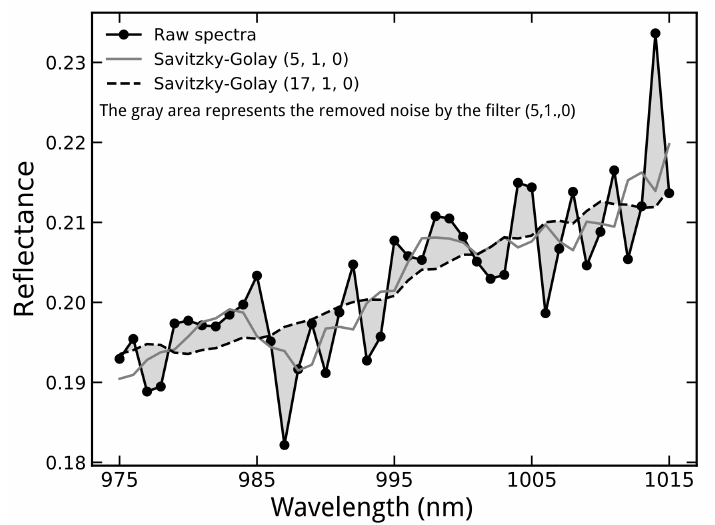
Figure 3. Effect of the Savitzky–Golay filter applied to a noisy spectral curve. No derivative transformation was used. Only forty points are displayed in order to appreciate its effect on noise. Inside the parentheses, window size, polynomial order and derivative order are